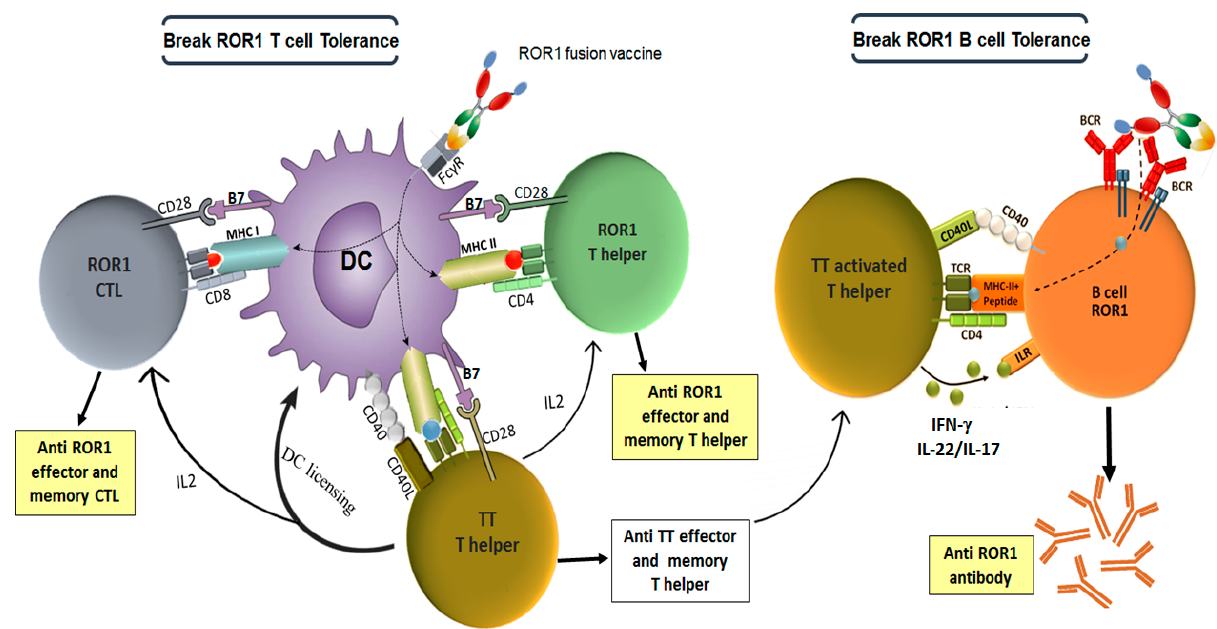
Figure 4. Proposed mechanism of action of TT-ROR1-Fc fusion proteins for activation of the humoral and cellular immune responses. (Left panel) pathways of provision of TT-specific CD4 T cell for DC maturation and breaking ROR1 T cell tolerance: main property of the ROR1 Fc-fusion protein is its ability to bind Fc γ receptors (Fc γ R), subsequently proteins are internalized by DC. This type of endocytosis promotes cross-presentation via MHC class I and II molecules, thereby priming both CD4 and CD8 T-cell responses. At first TT-specific CD4 T cells activated by the fusion protein, secrete IL-2, pro-inflammatory cytokines, and further activate the DC licensing, promoting the development of ROR1 specific T CD4/T CD8 via increasing costimulatory molecules on the DC (such as B7) and secreting cytokines. (Right panel) pathways of provision of TT-specific CD4 T cell help for ROR1-B cells: B lymphocytes recognize the ROR1 TAA through their BCR. BCR signaling and cytokines secreted by activated TT-specific CD4 T cells results in B cell activation and differentiation into ROR1 antibody producing plasma cells.